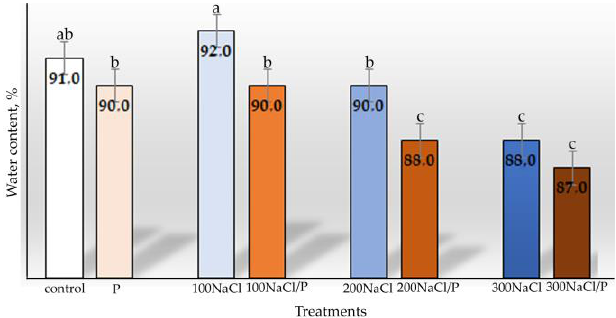
Figure 2. Dependence of the water content in the leaves of young Chenopodium quinoa on the stress conditions. The values shown are means (±SD). Different letters above the bars indicate a significant difference at p ≤ 0.05.